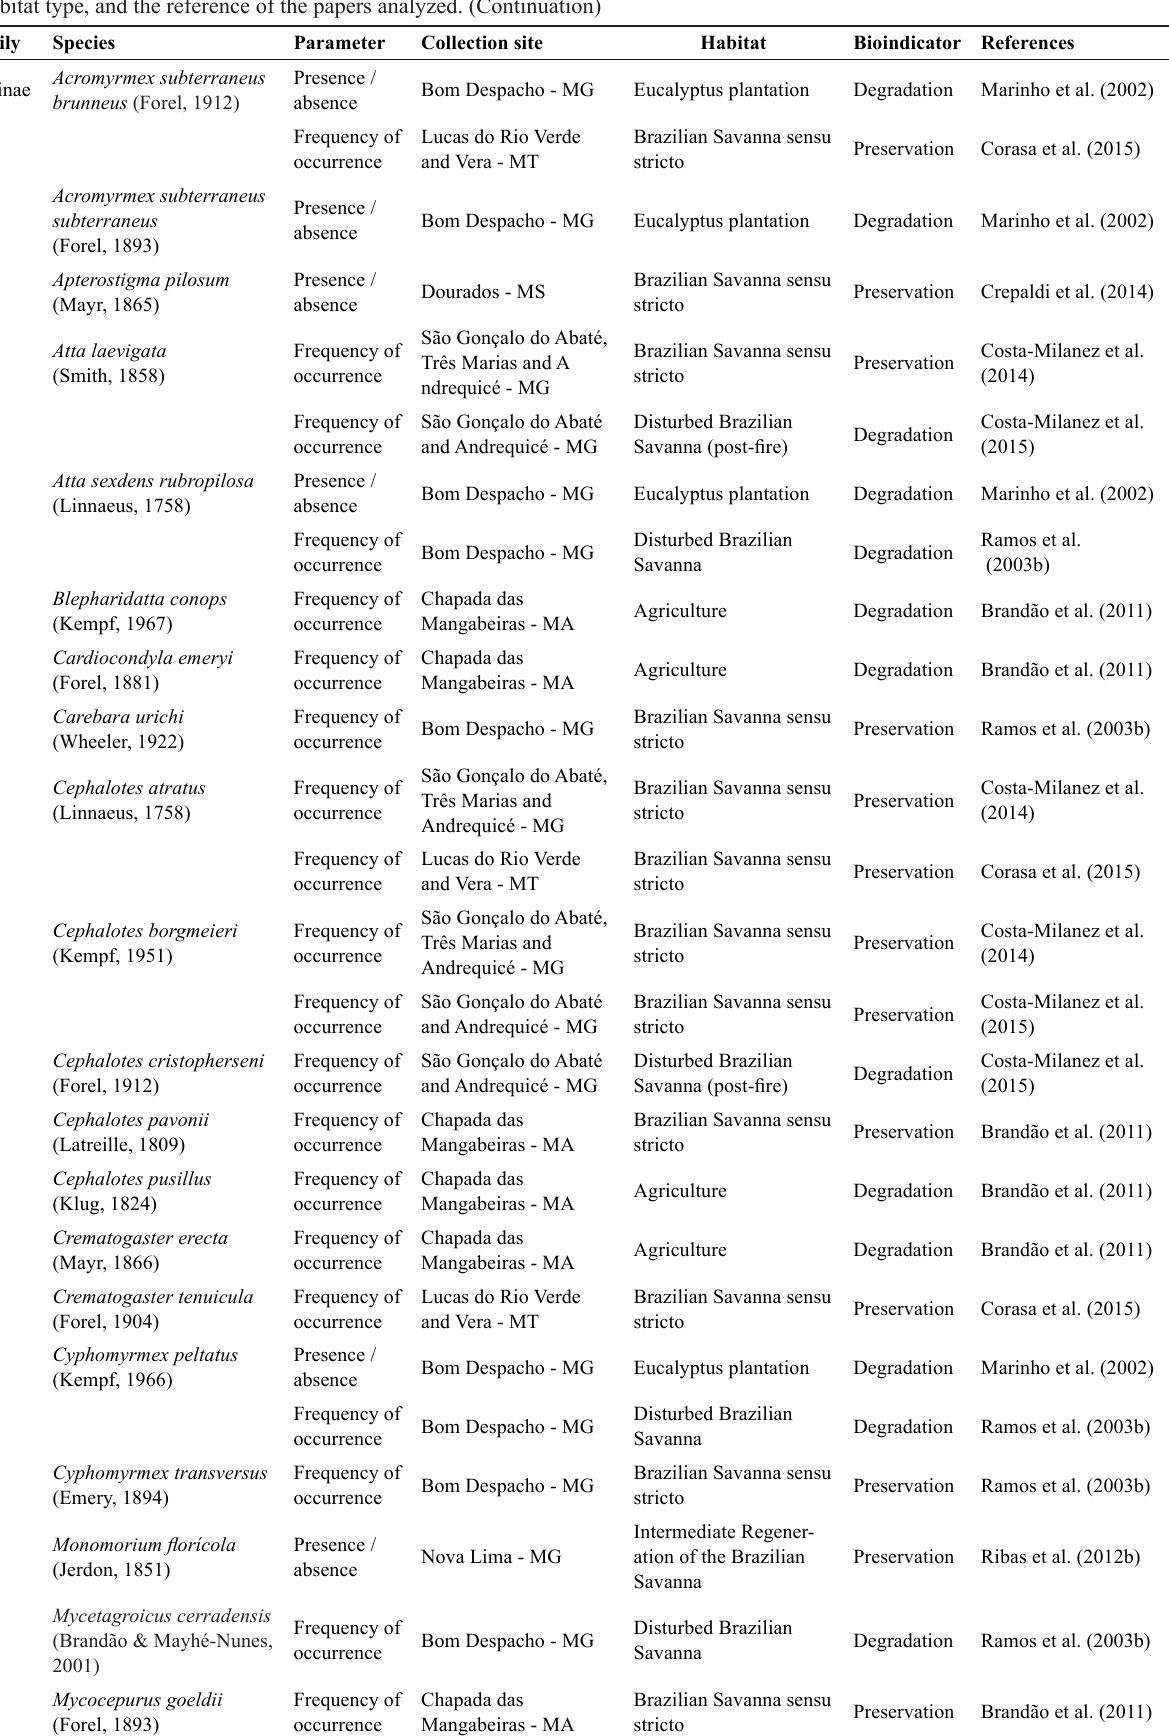
Table 3. Species of ants defined as bioindicators for preservation or degradation in the reference studys, indicating the parameter used to relate to the habitat type, and the reference of the papers analyzed.